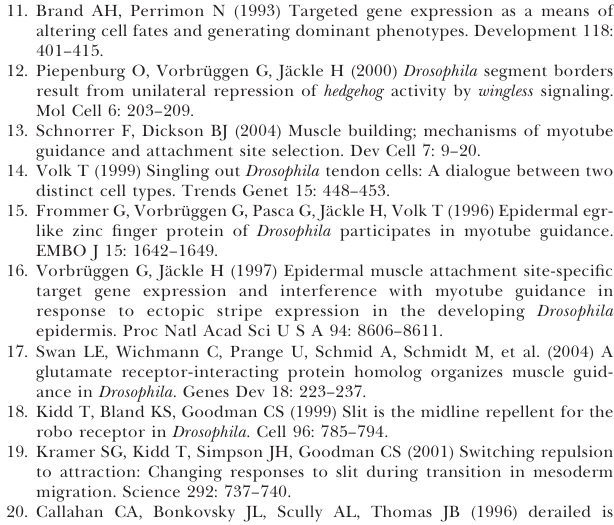
kept in the Bloomington Stock Center (Line). The former name as used in Table 1 (Old Name) is also listed. The chromosome arm (Arm) as well as the position according to D. melanogaster genomic sequence release 4.1 (Coordinate) is shown. The next gene (Gene) with its extension (5 9 Gene and 3 9 Gene, respectively) and orientation (Strand) as well as the relative position of the insert to the gene (Position) is indicated. The 5 9 sequence tag for each insertion line is listed under Sequence. Table S3. Identified Candidate Genes The candidate genes are arranged into groups by their proposed biological function. For each candidate, the CG number (according to the FlyBase [http://flybase.bio.indiana.edu/]), the gene synonym, the EP number, the orientation of the expressed transcript, predicted protein domains, the biological process, the expression pattern, the criteria for the validation of candidate genes, and a description of the gain-of-function muscle phenotype are listed. The wild-type expres- sion patterns are based on the Berkeley Drosophila Genome Project in situ expression data [39], Berkeley Drosophila Genome Project CHIP- expression data, or in situ hybridization using either genomic fragments (gen frag) or Ests. In this case the name of the Est used is listed. Abbreviations used to describe the expression are as follows: Ap, muscle attachment sites; Br, brain; Ep, epidermis; Fb, fatbody; Gc, garland cells; Go, gonads; He, heart; Hg, hindgut; mat, maternal expression; Md, early mesoderm; Mg, midgut; Ml, ventral midline; Mu, muscles; Nb, neuroblasts; Pc, pericardial cells; Sb, epidermal segment border; Sg, salivary glands; Tp, tracheal placodes; Ts, tracheal system; zyg, zygotic expression. The criteria used to validate the identified candidate genes were (1) reversion of the EP-element, (2) induction of expression, (3) similar phenotype induced by an UAS cDNA trans- gene, (4) additional EP-element, and (5) published data. Anti-sense candidates were only considered in the absence of a gene in sense orientation within 10 kbp downstream of the EP-element (6). Found at DOI: 10.1371/journal.pgen.0010055.st003 (180 KB